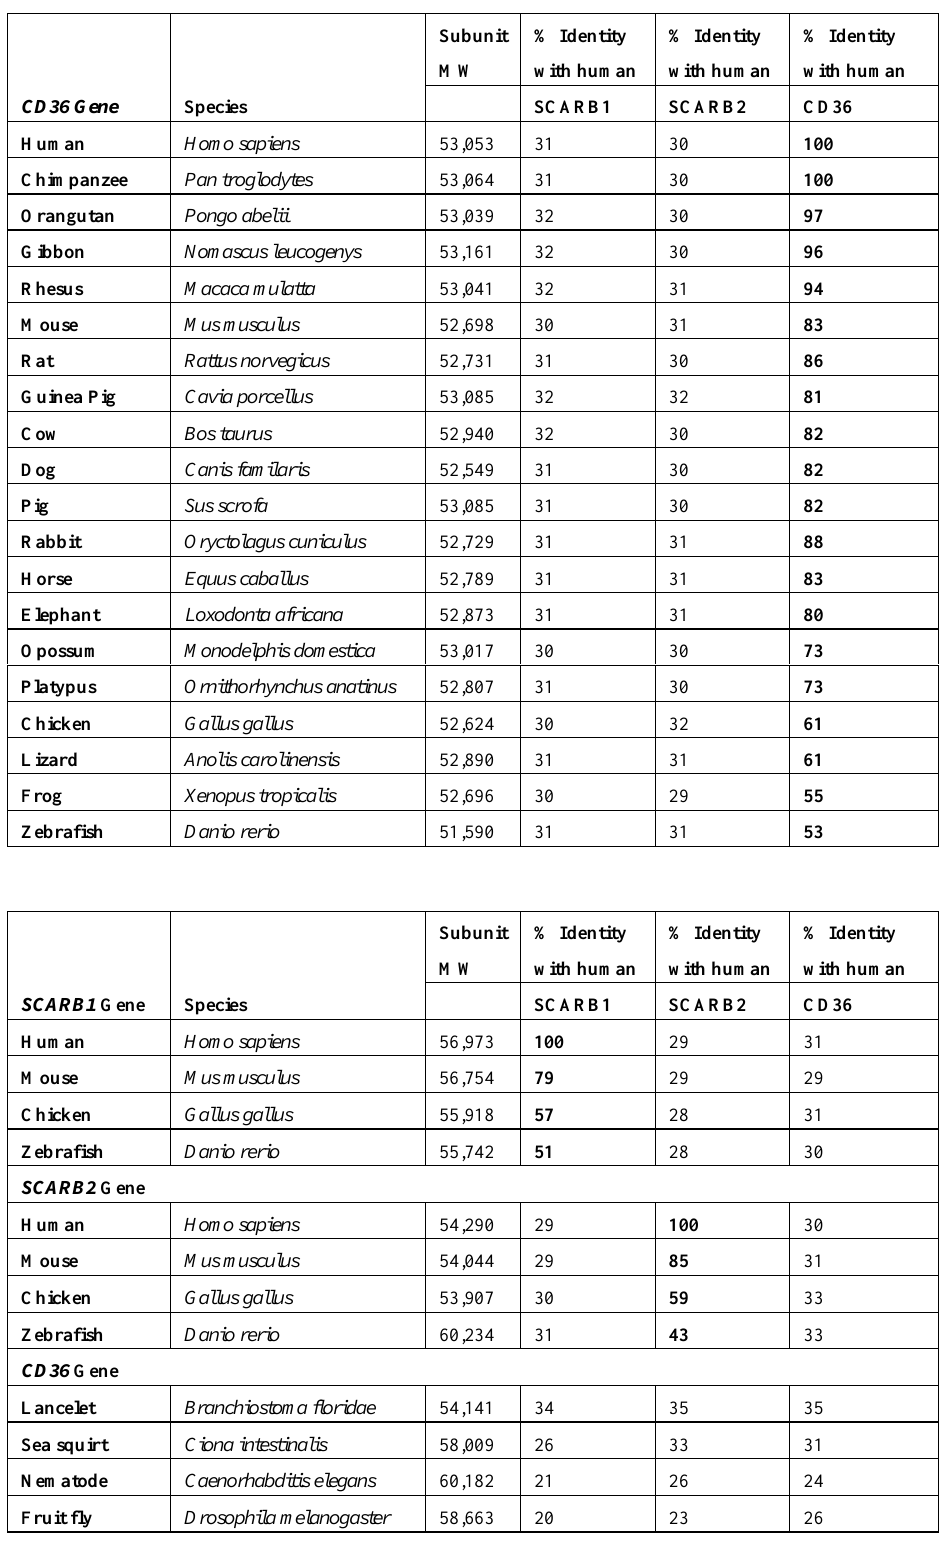
Supplementary Table 1. CD36, SCARB1 and SCARB2 proteins: subunit MWs and percentage identities. High % identities are in bold